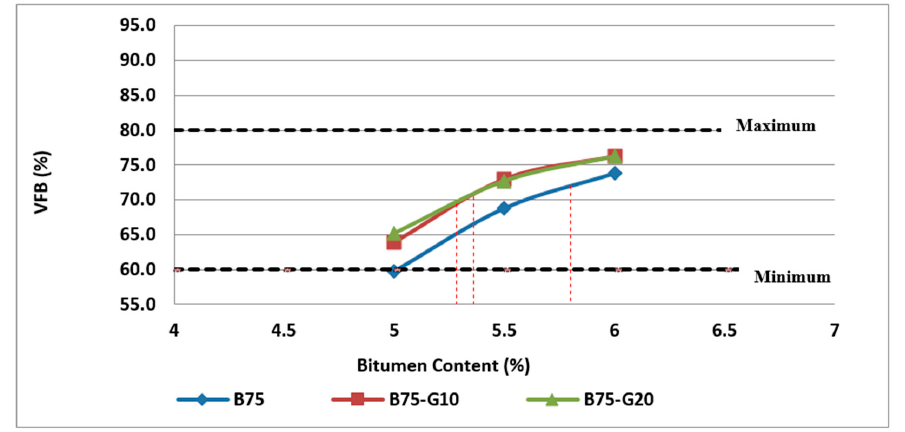
Figure 18. Effect of bitumen content and glass content on VFB of Mix II containing 25% RCA without glass and Mix IV and Mix V containing 25% RCA as coarse aggregate and glass as fine aggregate.